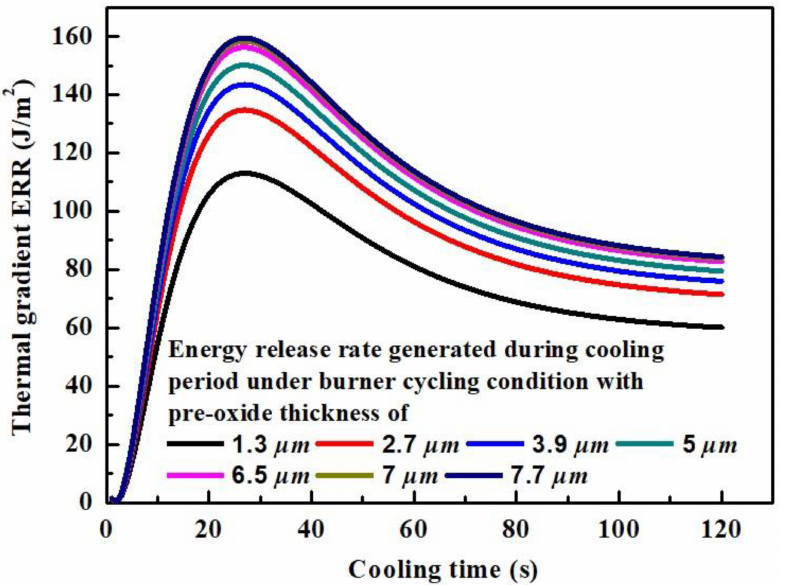
Figure 15. The calculated thermal gradient ERR developed upon cooling vs. the time at different pre-oxide TGO